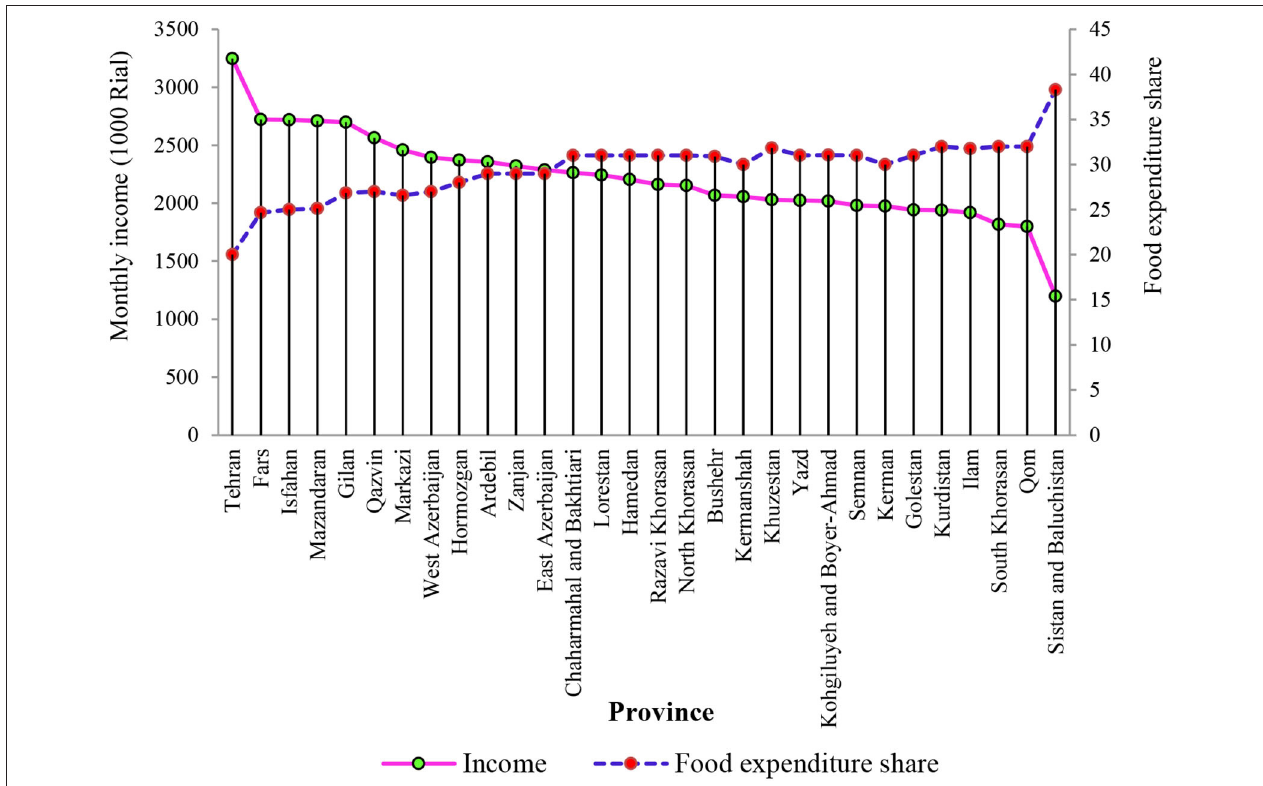
FIGURE 1 | The relationship between monthly income and food expenditure share in all provinces in Iran. Source: study